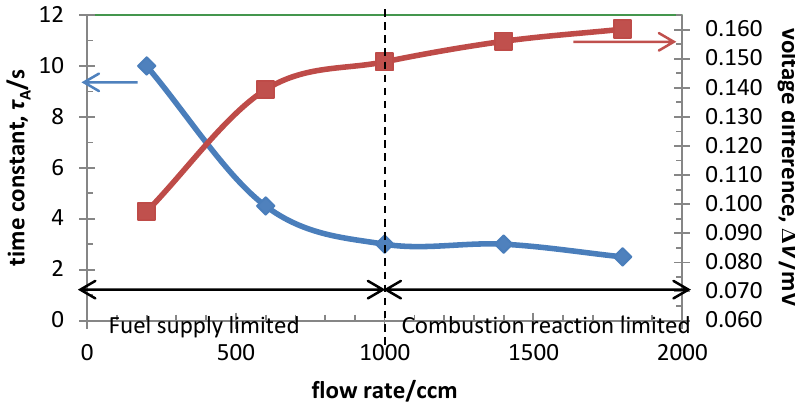
Figure 4. Experimental response curve of the TGS in the gas at a flow rate of 1,800 ccm of 200 ppm and 1,000 ppm H in air. The catalyst of the TGS device was heated up to 120 °C 2 by its micro-heater. H flow was from 30 to 60 s. The thermal time constant τ 2 as the elapsed time from 60 s to decreasing at 63.2% of the  V